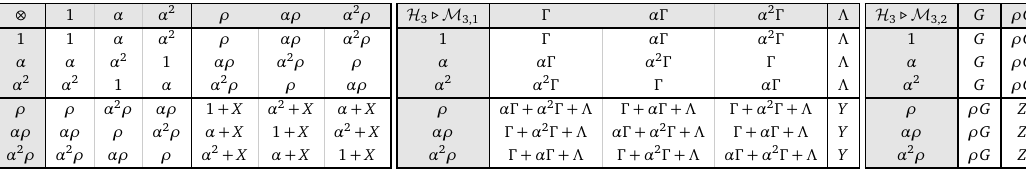
Table 1: Fusion rules for and (left) and module fusion rules (middle and H 2 H 3 right). The category is rank 6, with a full subcategory, generated by { 1, α , α 2 } , H 3 equivalent to Vec ( (cid:90) / 3 (cid:90) ) . We define X = ρ + αρ + α 2 ρ , Y = Γ + α Γ + α 2 Γ + Λ , and Z = G + 3 · ρ G . Fusion rules for the modules were obtained from [ 9 ]